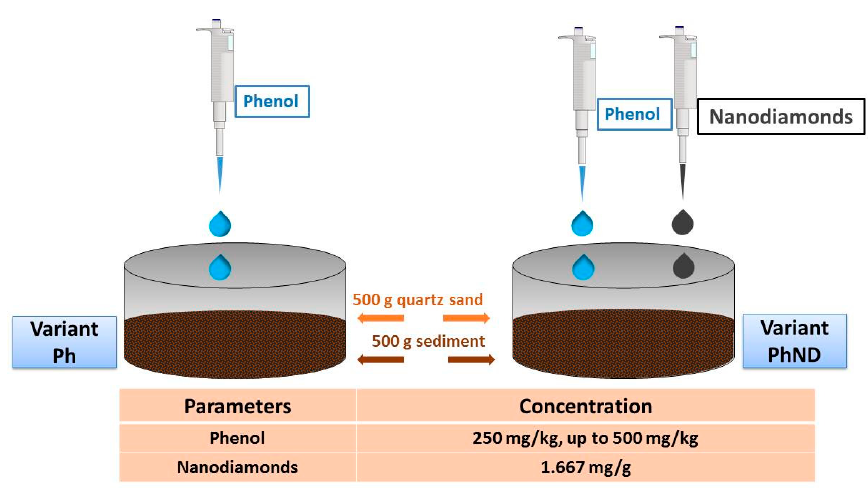
Figure 1. Experimental design.